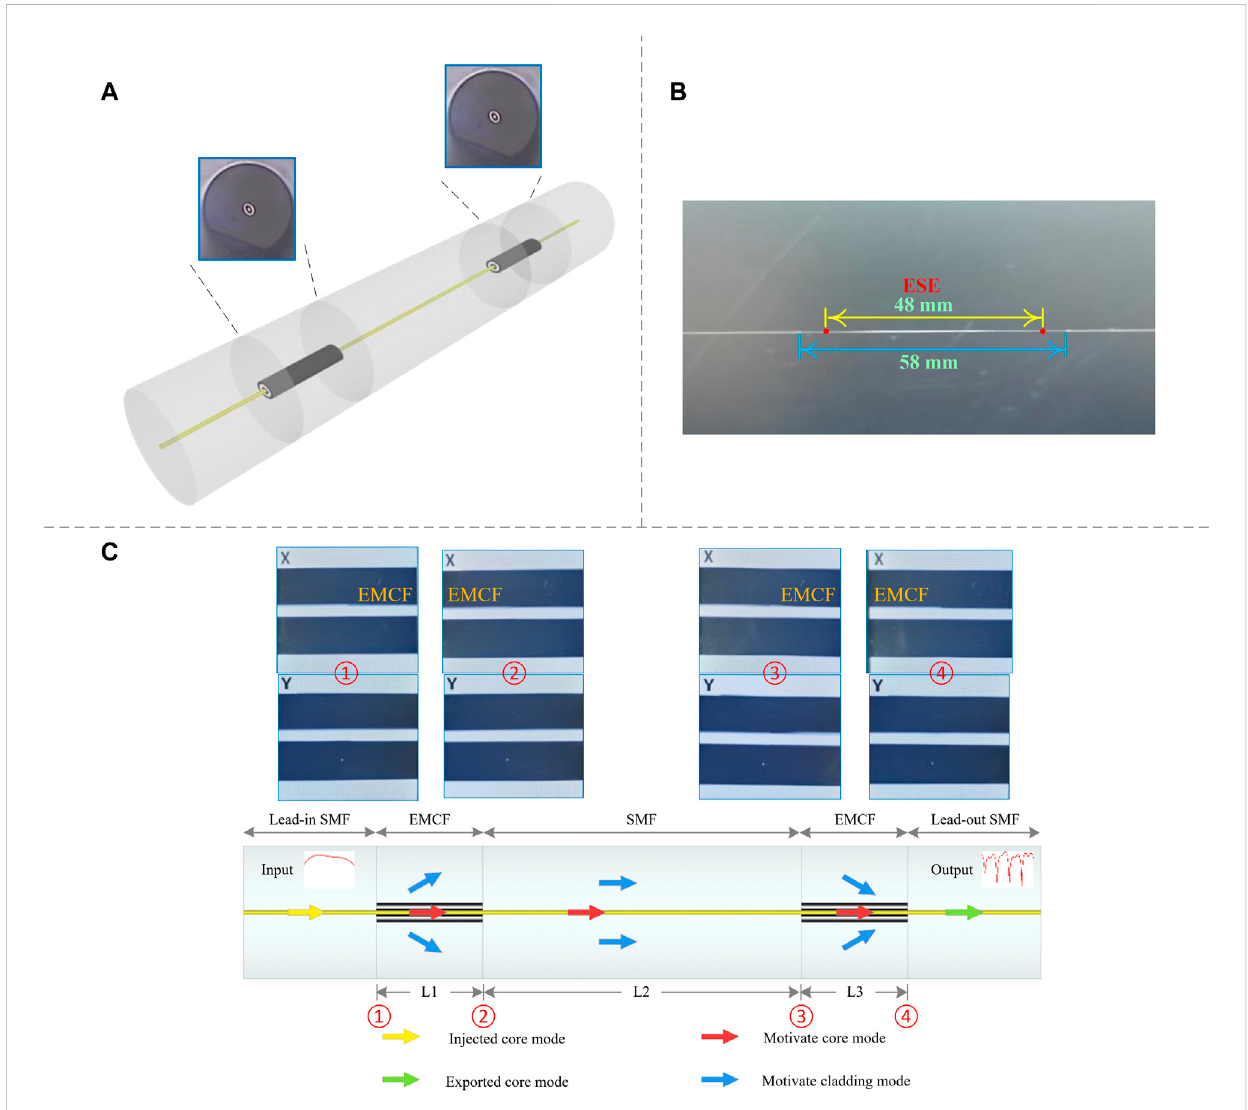
Details of the proposed sensor, (A) the three-dimensional structure; (B) the close view and geometrical sizes; (C) the representation and